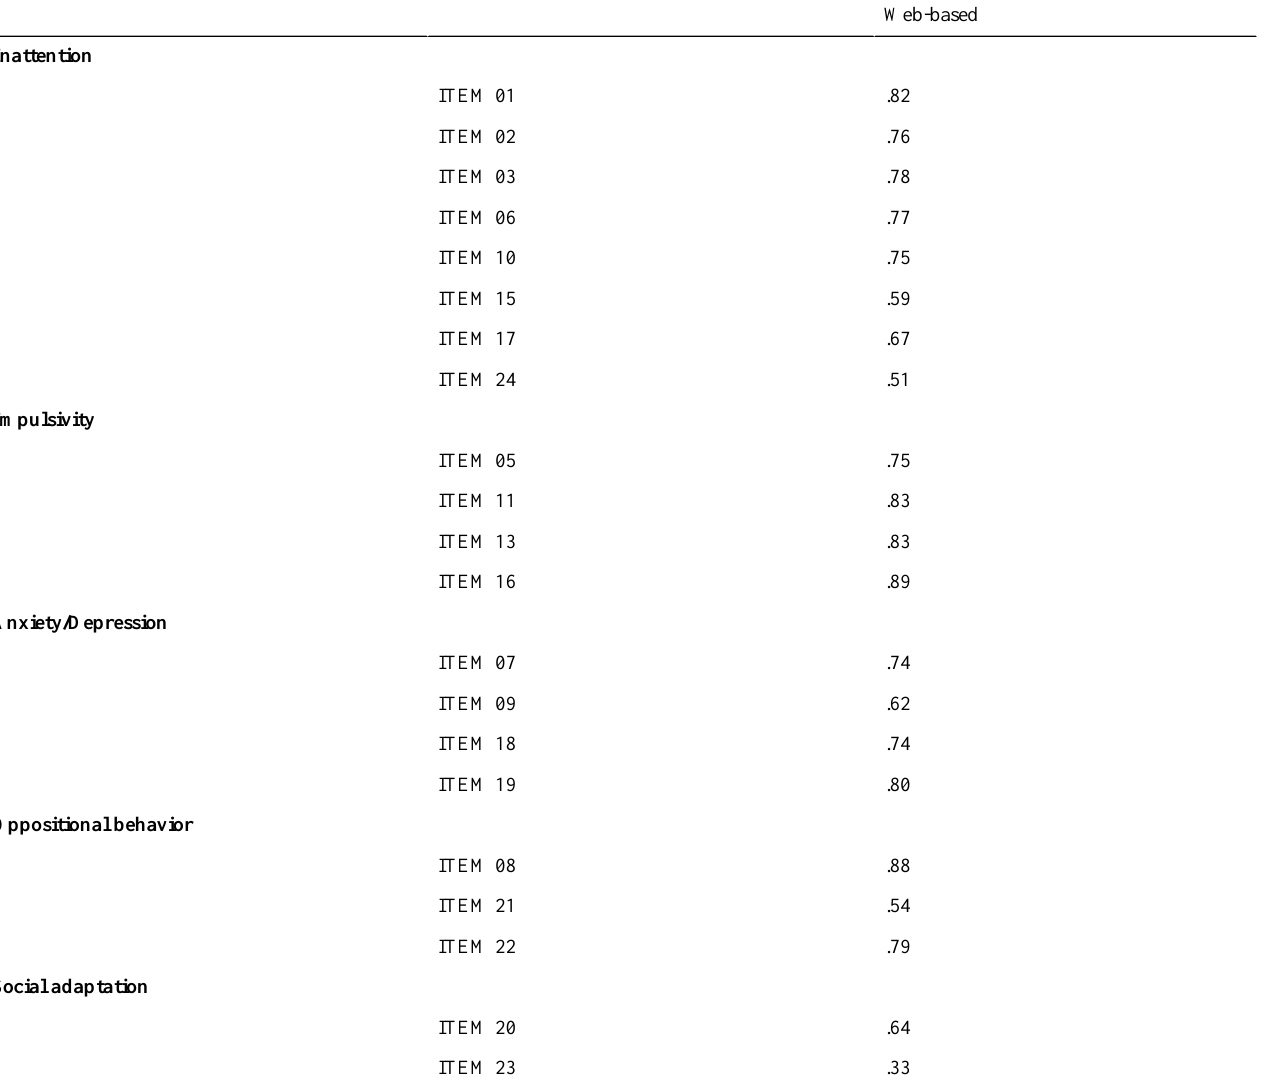
Table 5. Correlations of WURS-k items (loadings) with their postulated factors (latent constructs) in the Web-based sample.